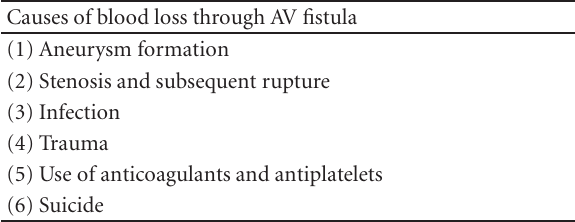
Table 1: Causes of blood loss through AV fistula. Causes of blood loss through AV